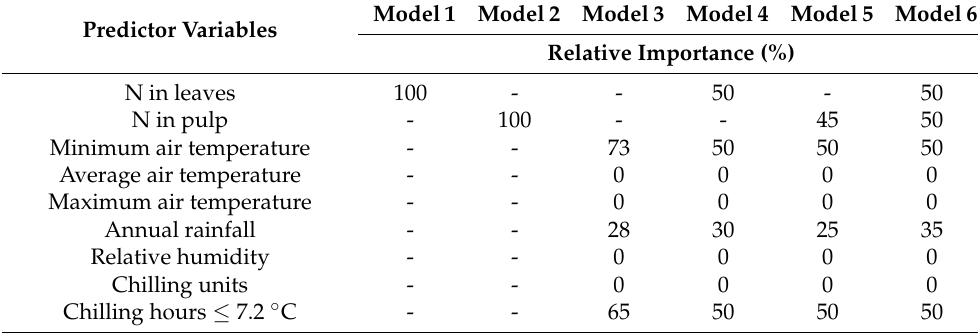
Table 2. Relative importance of predictor variables included in the calibration of yield prediction models of ‘Fuji Suprema’ and ‘Royal Gala’ apple trees subjected to nitrogen